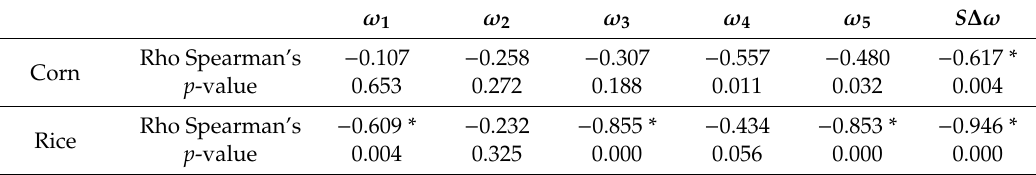
ω ω ω ω ω ∆ ω 1 2 3 4 5 S